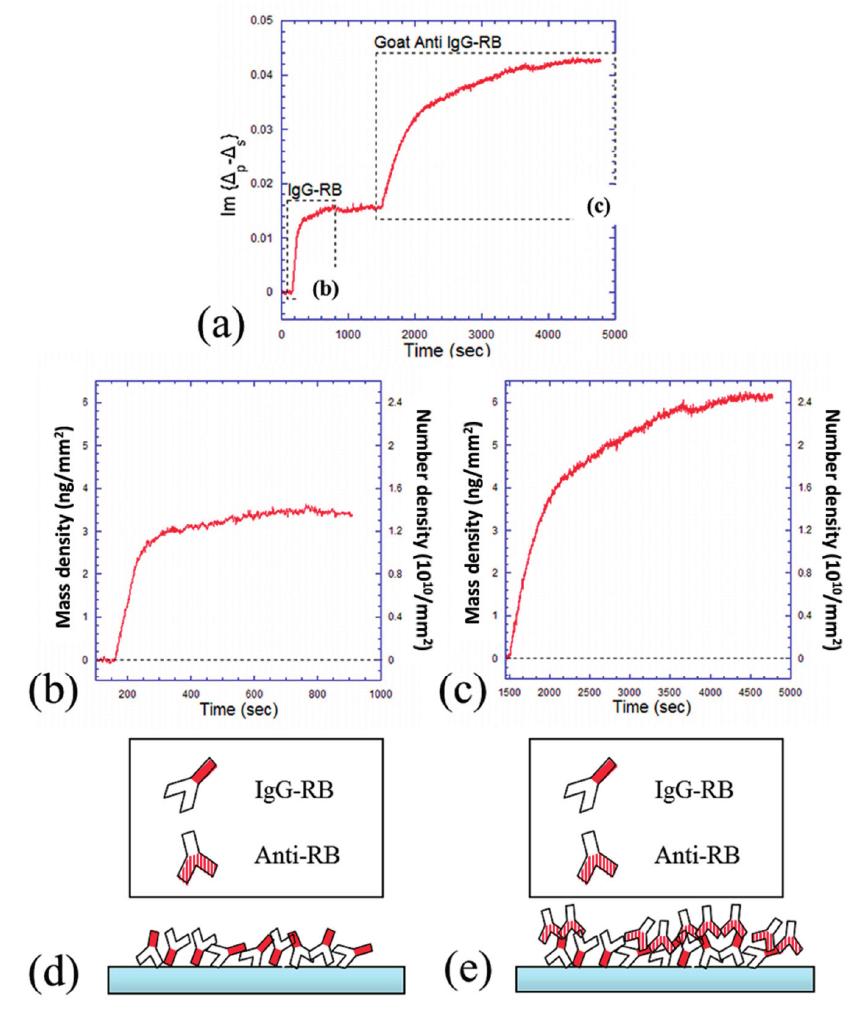
Figure 3. Kinetics of antibody-antigen capture. ( a ) OI-RD detection of antigen (67 nM of IgG-RB) binding to epoxy surface and following antibody (33 nM of Goat Anti-RB) binding to antigen; ( b ) Kinetic curve of IgG-RB binding to epoxy surface; ( c ) Kinetic curve of Goat Anti-RB binding to IgG-RB; ( d ) Cartoon depiction of process (b); ( e ) Cartoon depiction of process